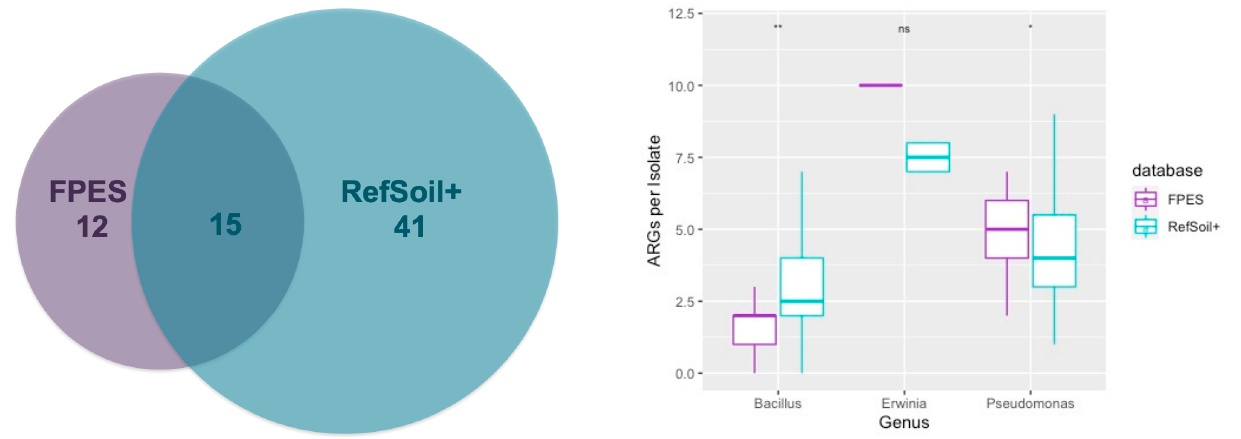
Figure 6. ( a ) Types of ARGs by database ( b ) Boxplot of the number of antibiotic resistance genes per isolate by genus and database (FPES vs RefSoil+). Wilcoxon test significance p < 0.01 **, p < 0.05 *, >0.1 ns. Table 2. List of ARGs found on plasmids in FPES Isolates along with description of each ARG’s resistance mechanism, drug class, gene family, and FPES host